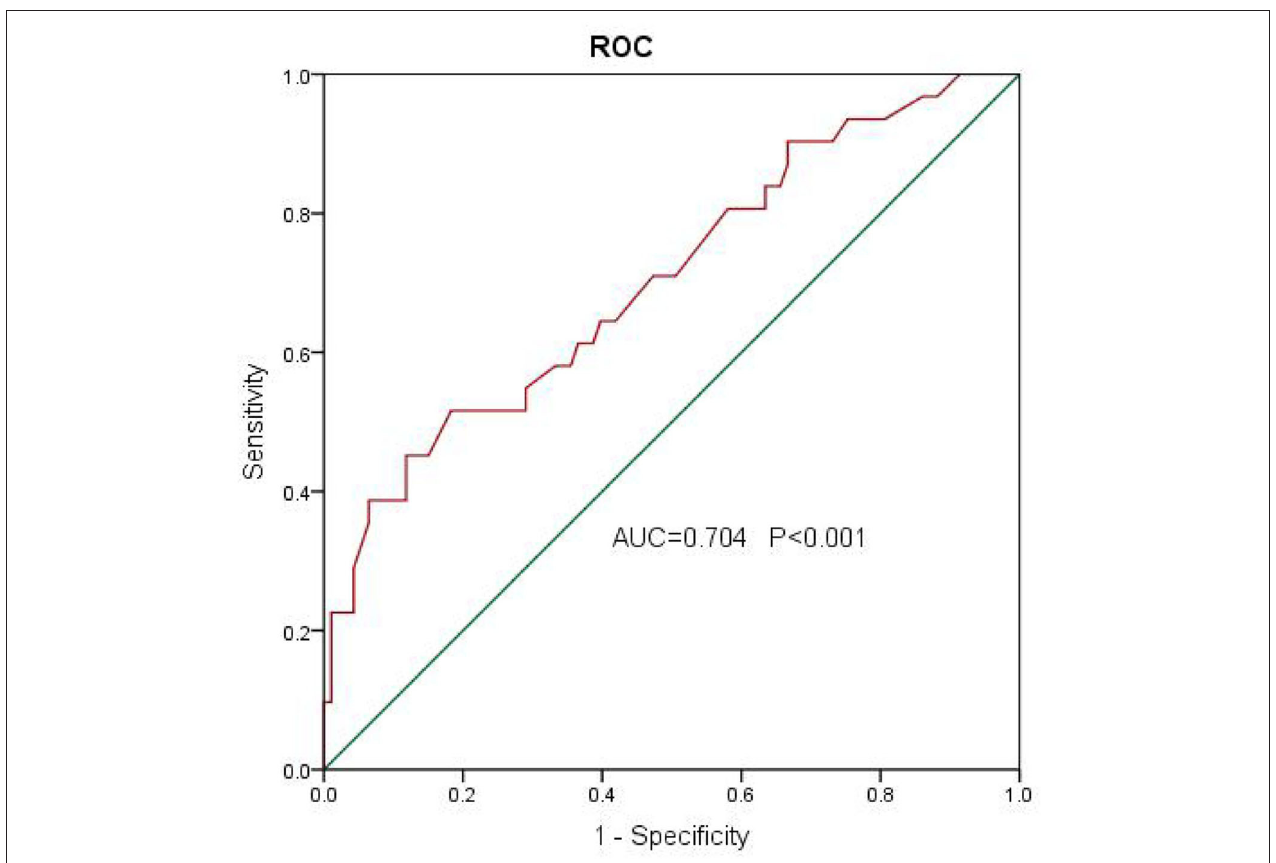
FIGURE 2 | A receiver operating characteristic analysis revealed a moderate accuracy of predicting the improvement of left ventricular ejection fraction (LVEF) by E/E ′ with a cut-off of 15 (sensitivity: 38.7%, specificity: 89.2%, area under the curve: